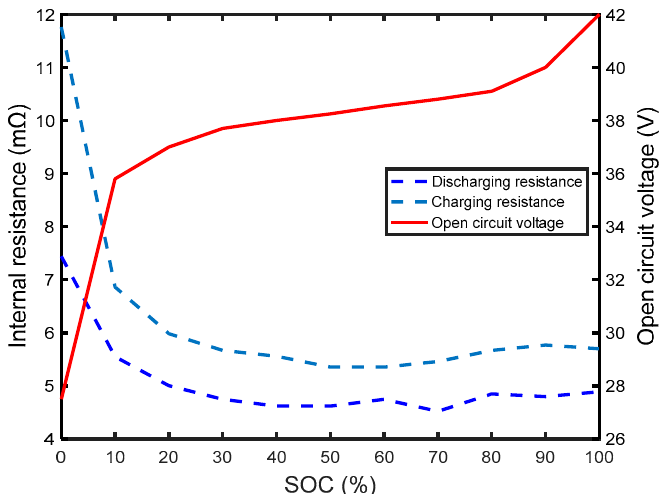
Figure 2. The internal resistance and OCV relative to SOC (10 cells).